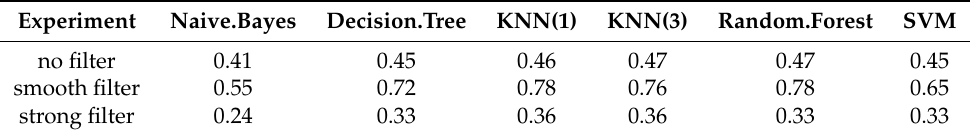
Table 4. Validation for a paticular combination of weather condition rain-dry-storm . Experiment